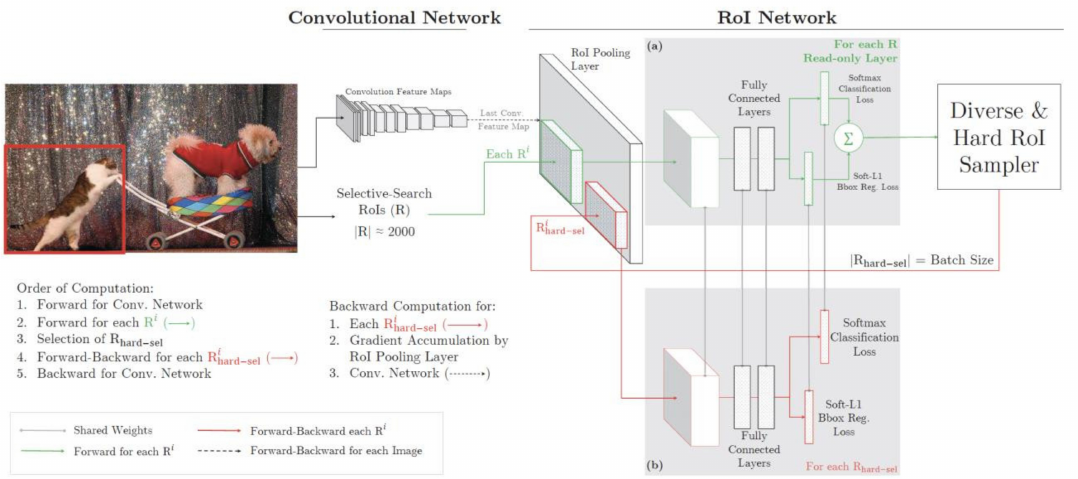
Figure 7. Architecture of the proposed training algorithm specified as part (ii) in Figure 5: the proposed training algorithm: input image, selective search of RoIs, and computation of a conv feature map by the conv network. In ( a ), the read-only RoI network runs a forward pass on the feature map and all RoIs (shown by green arrows). Then, the Hard RoI module uses these RoI losses to select B examples. In ( b ), these hard examples are used to compute forward and backward passes by the RoI network (shown by red arrows) [46].